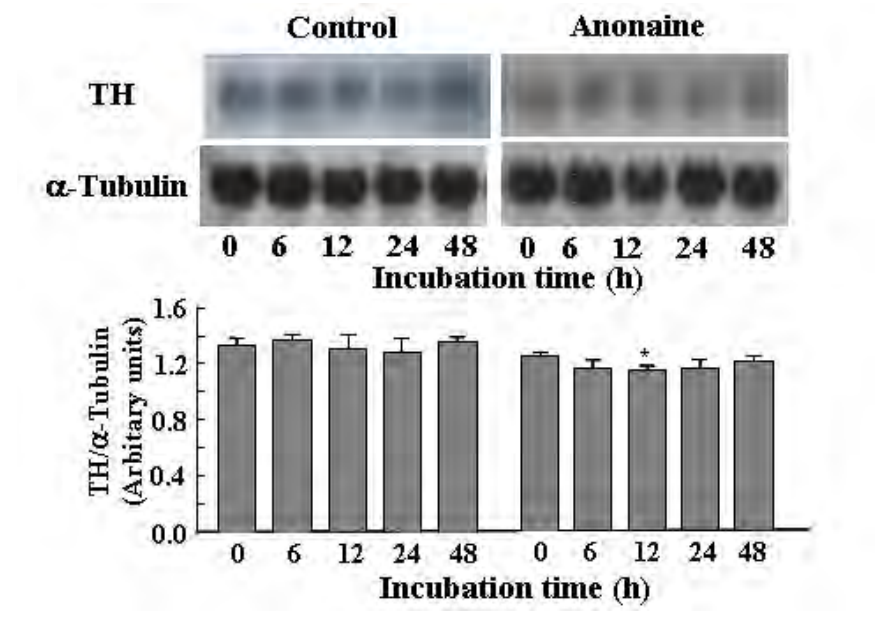
Figure 4. Effects of anonaine on TH mRNA levels in PC12 cells. RNA was extracted and 10 µg aliquots were subjected to electrophoresis on formaldehyde gels, blotted onto nylon membrane and probed with 32 P-labeled cDNA probes for rat TH and α -tubulin. Equal loading of the gels was verified by ethidium bromide staining of total RNA. Relative densitometry ratio in control was expressed as 1 arbitrary unit (means ± S.E.M., n=3). Significantly different from control values: *P<0.05 (ANOVA followed by Tukey’s